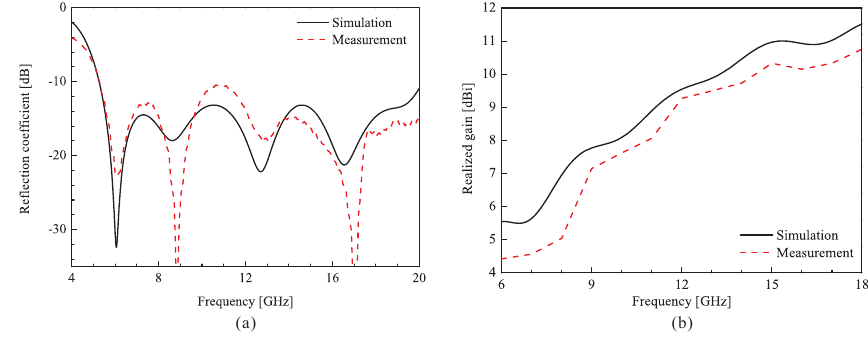
Figure 11. Simulated and measured results of the robustly optimized TEM horn antenna: ( a ) reflection coefficient and ( b ) realized gain.